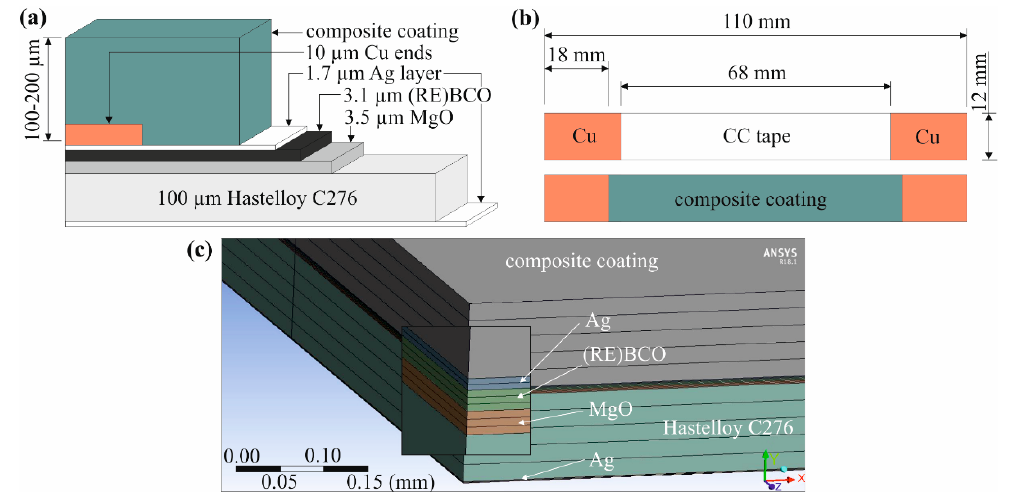
Figure 6. HTS tape sample coated with a composite layer: ( a ) configuration and thicknesses of the particular layers (not in scale); ( b ) dimensions of the sample for the model geometry; ( c ) FE mesh in the middle part of the model.